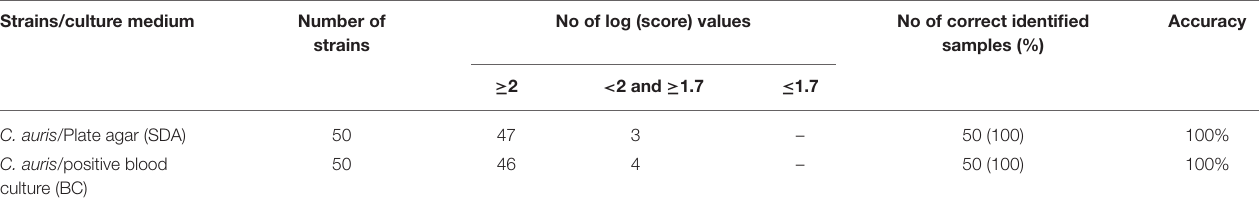
TABLE 1 | Identification of 50 C. auris isolates derived from SDA plate agar and positive blood cultures by MALDI-TOF MS, respectively. Strains/culture medium Number of No of log (score) values No of correct identified strains samples